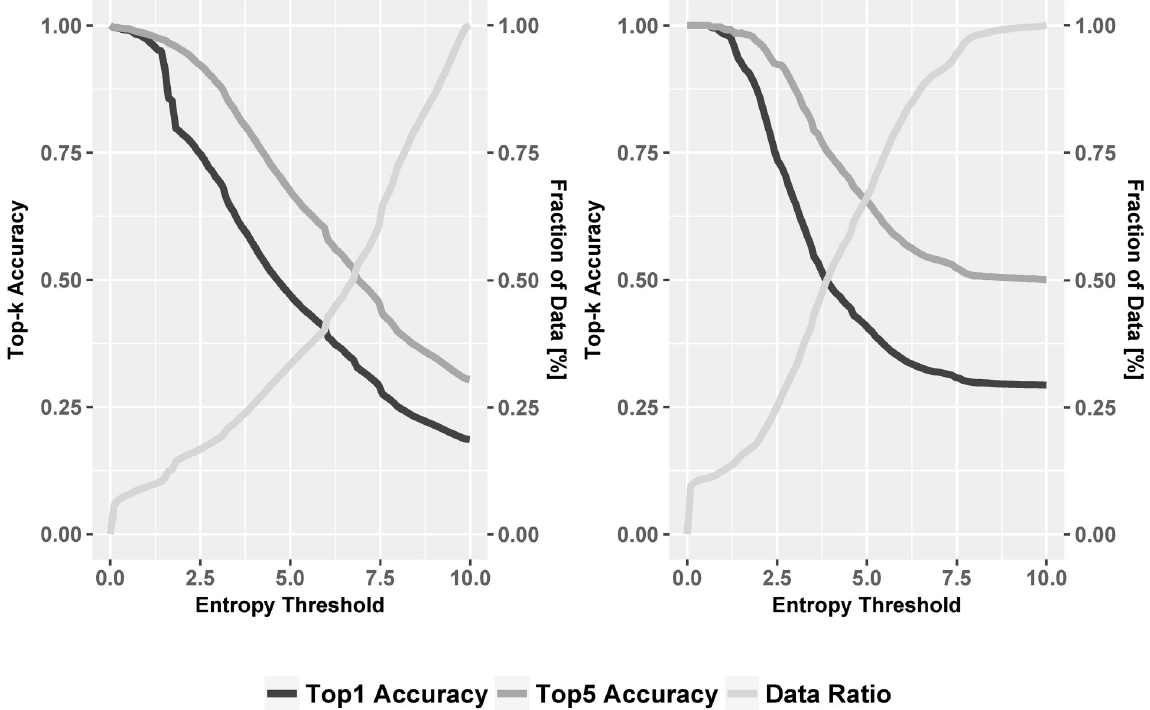
Fig 8. Line plot of entropy influence on accuracy (left: Row 1; right: Row 4 from Table 4).